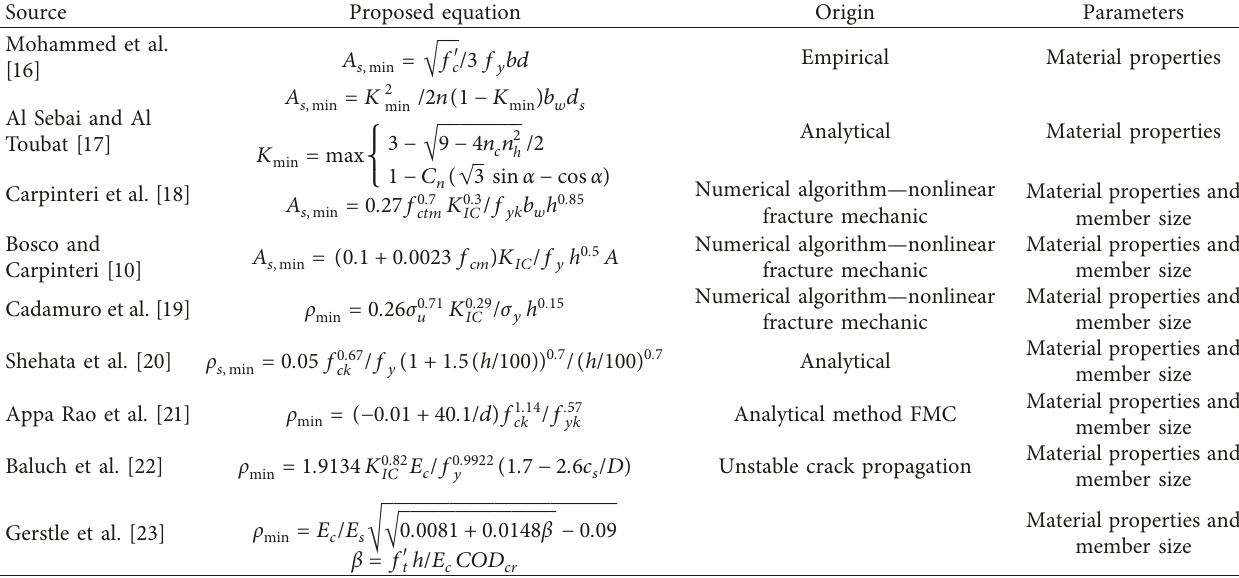
Table 2: Summary of previously proposed equations.